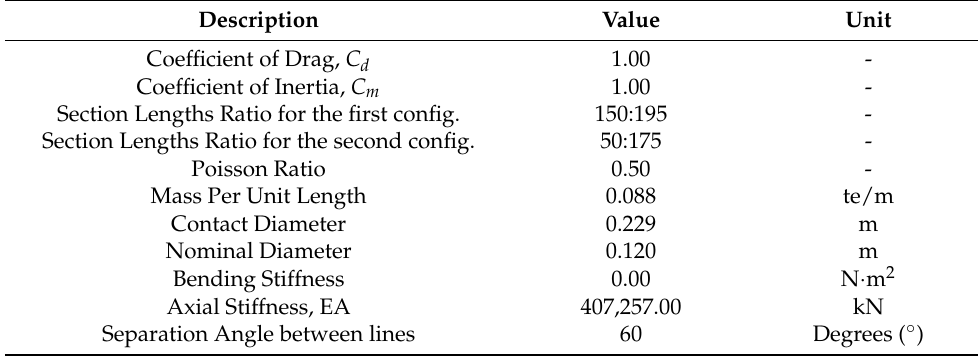
Table 4. Parameters for the mooring lines.